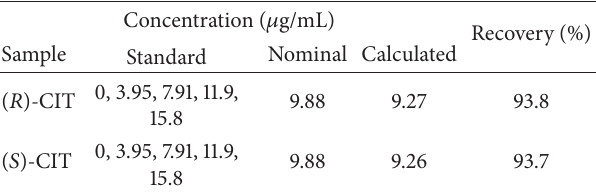
Figure 5: Typical chromatogram of CIT enantiomers. Mobile phase: aqueous buffer/methanol/acetonitrile of 21 :3 :1 (v/v/v), 5 mM sodium dihydrogen phosphate, 12 mM SBE- 𝛽 -CD, pH of 2.5, flow rate of 1.0mL/min, detection wavelength of 240 nm, temperature of 25 ∘ C, and injection of 10 𝜇 L and 0.22 mM of racemic CIT. Table 4: Test of the accuracy of ( 𝑅 )-CIT and ( 𝑆 )-CIT by standard